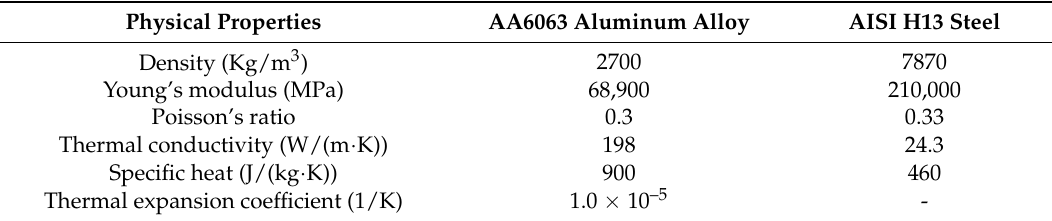
Table 1. Physical properties of AA6063 aluminum alloy and AISI H13 steel.